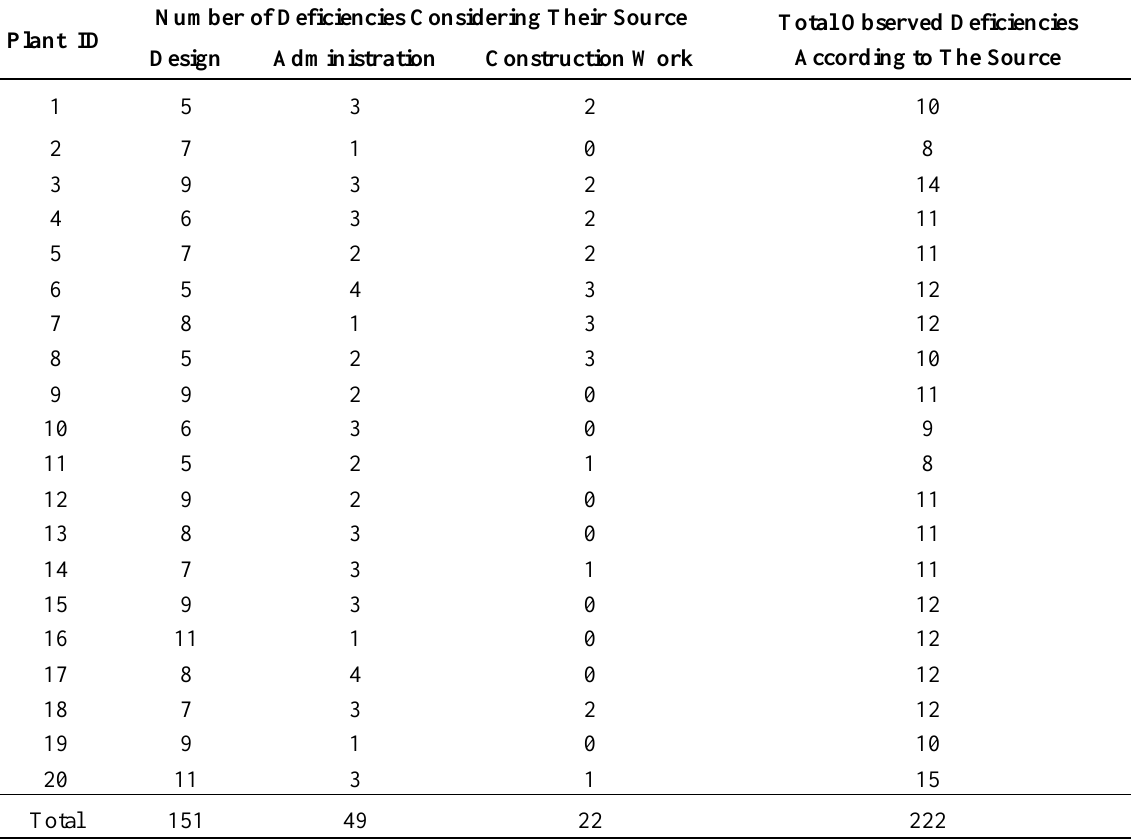
Fig. 5. Number of detected deficiencies, classified by category and source of deficiency. Table 4. Distribution of the various deficiencies at the 20 studied WWTPs.